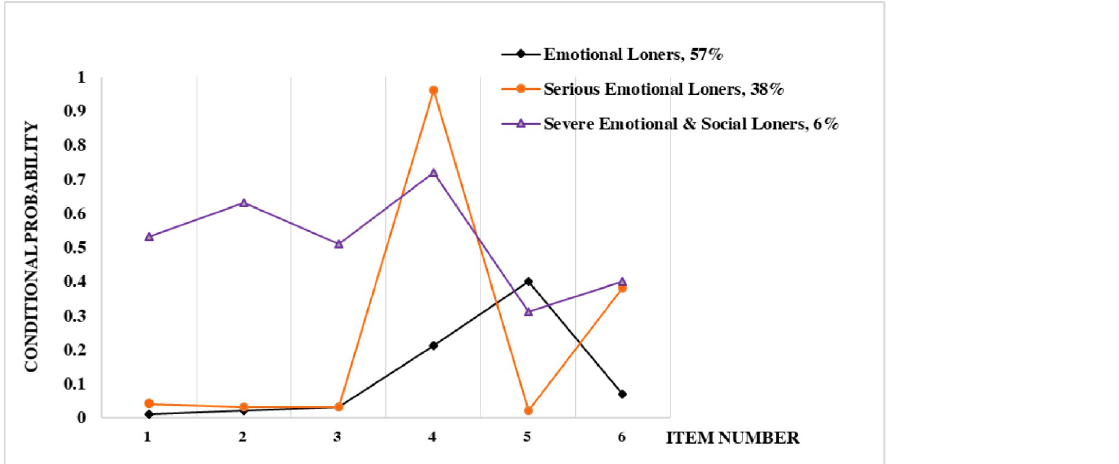
Fig 2. Latent class analysis for conditional probabilities by each loneliness item, stratified by three clusters.